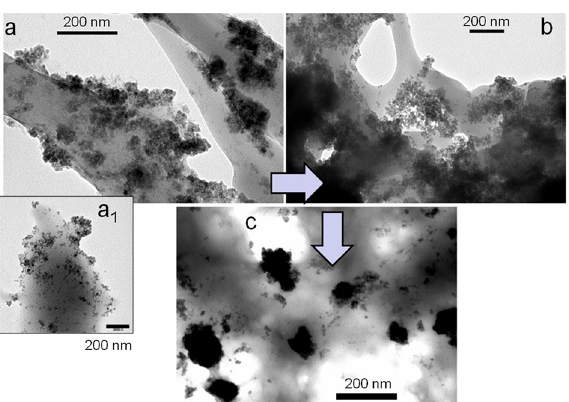
Figure 1. TEM image of the polymerization under different conditions: ( a - a 1 ) in absence of 3-bt: MNPs are deposited mostly on the surface of the thermoresponsive polymer, ( b ) with 3-bt to promote a terminal double bond over the NPs surface: Large aggregates of MNPs are embedded in the polymer matrix, and ( c ) using 3-bt and CTAB at room temperature: well defined microclusters of MNPs are